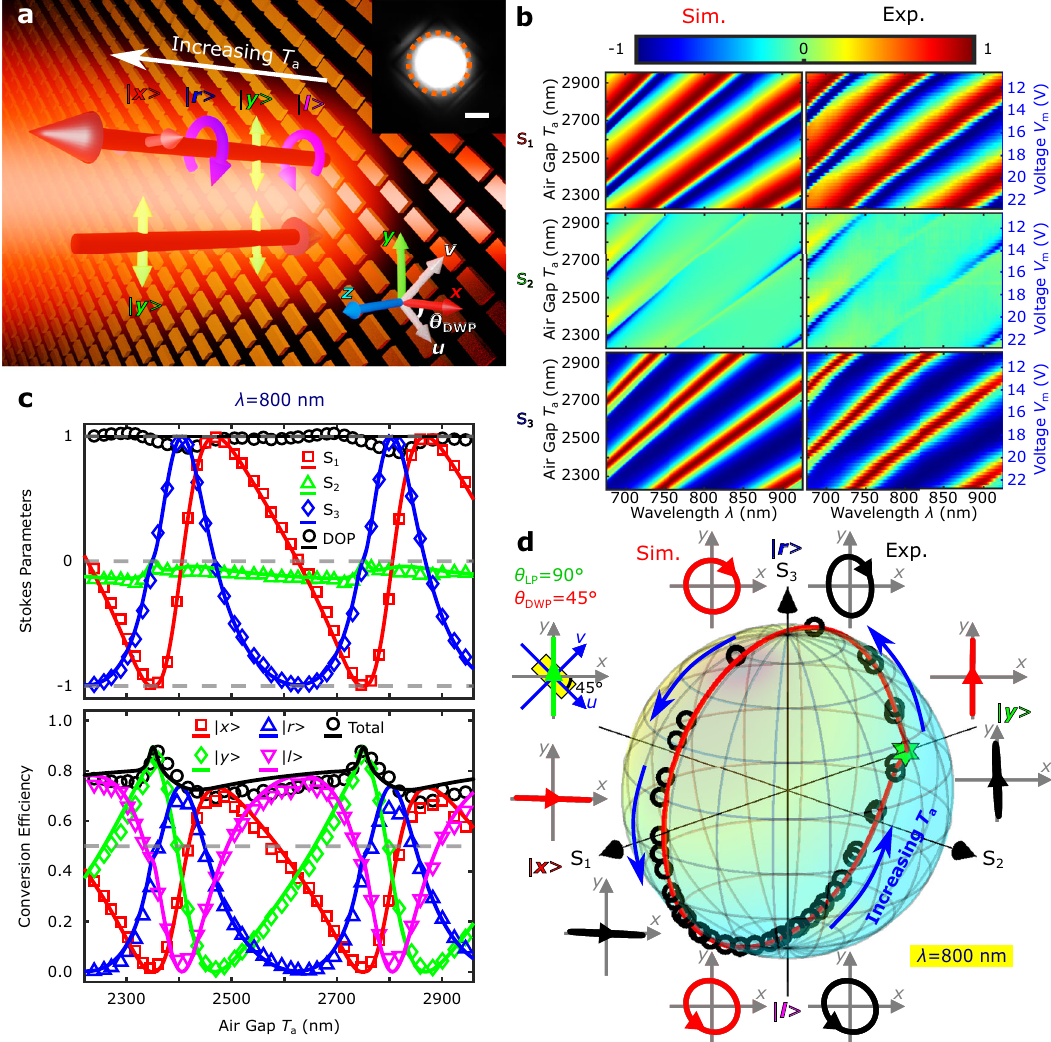
Fig. 2 Polarization transformations for the incident LP oriented at 45° with respect to the DWP axes. a Schematic of the dynamic wave plate (DWP) operation at the wavelength of 800 nm for the fi xed incident linear polarization (LP) state | y > ( θ LP = 90°) and DWP orientation θ DWP = 45°, illustrating the re fl ected light polarizations being continuously changed from | l > , | y > , | r > to | x > with increasing the ai r gap T a . The inset is a typical optical image of the optical metasurface (OMS) array illuminated with the incident laser spot con fi ned within the orange dashed circle. The scale bar is 10 μ m. b Calculated (left) and measured (right) normalized Stokes parameters ( S 1 , S 2 , S 3 ) of the re fl ected light as a function of the air gap T a and light wavelength λ . c Calculated (lines) and measured (markers) normalized Stokes parameters (above) and polarization conversion ef fi ciencies (below) as a function of the air gap T a for the light wavelength λ = 800 nm. d Calculated (line) and measured (circles) polarization trajectory on the Poincaré sphere mapping the re fl ected light polarization evolution shown in ( c ). As the air gap T a increases, the re fl ected polarization state revolves repeatedly around the sphere. The green star marks the incident LP state: | y >. The calculated (red) and measured (black) polarization ellipses illustrate the polarization contrast between the main orthogonal polarization states (| x > and | y > , | r > and | l > ) realized by tuning the air gap T a